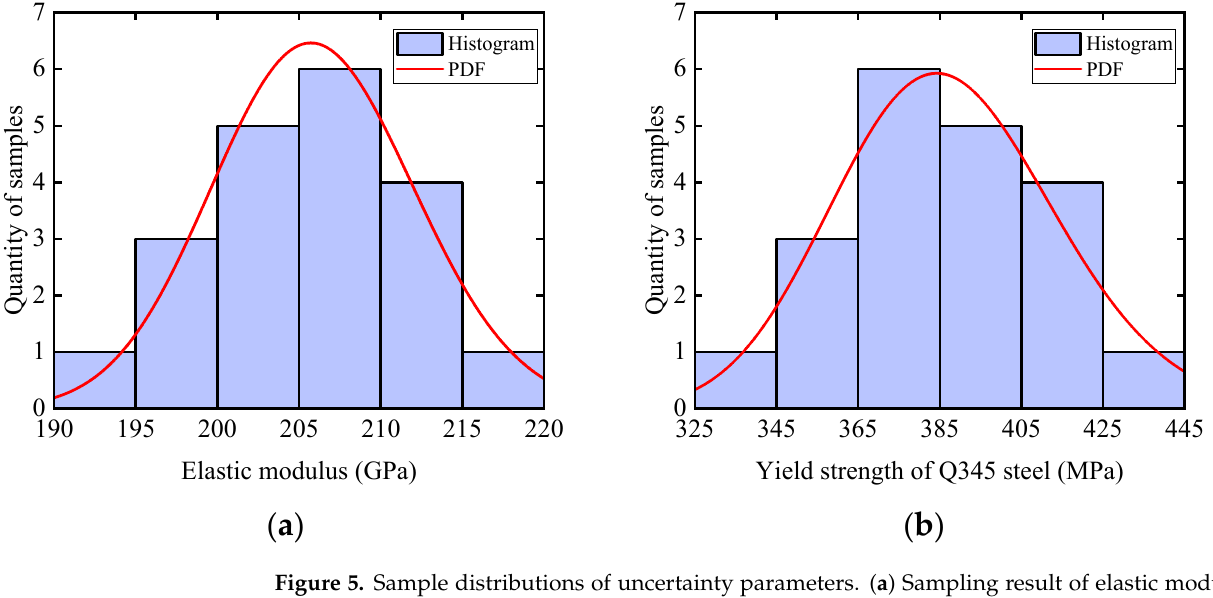
Figure 5. Sample distributions of uncertainty parameters. ( a ) Sampling result of elastic modulus. ( b ) Sampling result of yield strength of Q345 steel.